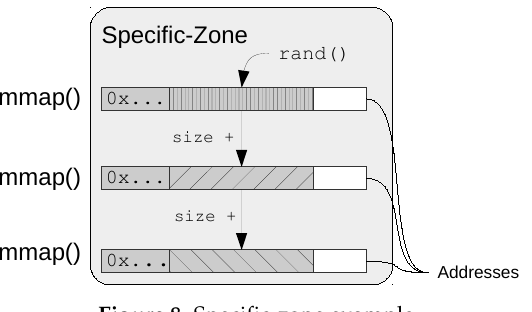
Figure 8. Specific-zone